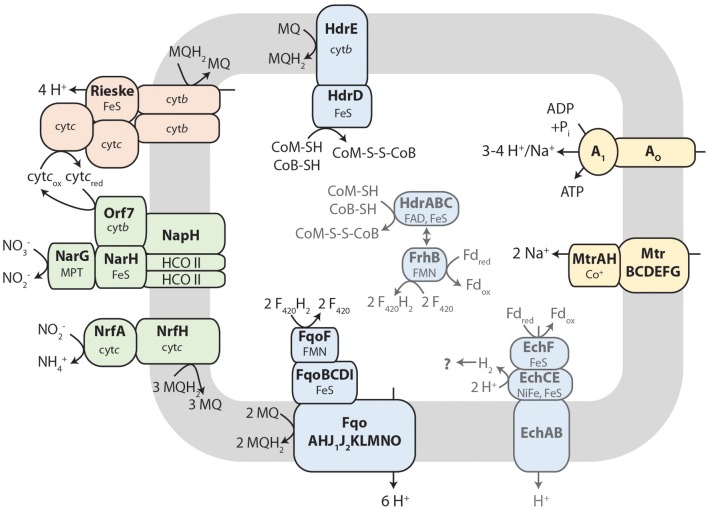
Tentative metabolic pathway model of membrane-bound electron transport in Methanoperedens. Reverse methanogenesis produces F420H2 and the thiol cofactors CoM-SH and CoB-SH as well as reduced ferredoxin (Fdred). F420H2 may be oxidized by the F420H2 dehydrogenase (Fqo) and electrons transferred to menaquinone (MQ, menaquinone; MQH2, menaquinol). The heterodisulfide reductase (Hdr) reaction is reversed resulting in quinone reduction upon CoM-S-S-CoB (heterodisulfide) production. Menaquinol can be oxidized by a Rieske-cytochrome b complex comprising two additional cytochrome c subunits. Electrons are transferred to an unusual nitrate reductase (Nar) complex, presumably via soluble cytochrome c (cytcox/red, oxidized/reduced cytochrome c), to reduce nitrate to nitrite. A small part of the nitrite can further be reduced to ammonium by nitrite reductase (Nrf) with menaquinol as electron donor. The fate of reduced ferredoxin is unclear. It could either be oxidized by Ech hydrogenase, by FrhB or FqoF (homologous to each other) alone or by the hypothesized confurcating HdrABC-FrhB enzyme complex. For more details, see text. Methyltransferase (Mtr) and A1AO ATP synthase make use of the proton motif force built up by the respiratory chain. This metabolic construction is solely based on genome analysis. HCO II, heme copper oxidase subunit II like proteins; cytb, cytochrome b; cytc, cytochrome c; FeS, iron-sulfur cluster; FMN, flavin mononucleotide; FAD, flavin adenine dinucleotide; MPT, molybdopterin; NiFe, nickel-iron center.